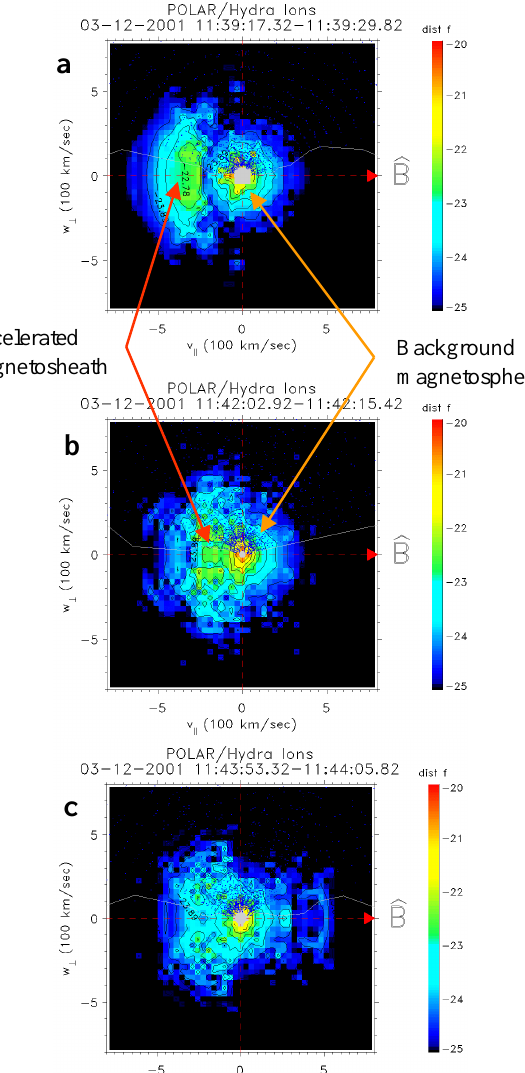
Fig. 7. Ion distribution plots for the interval of first contact with the magnetopause indicated by the first circle in Fig.